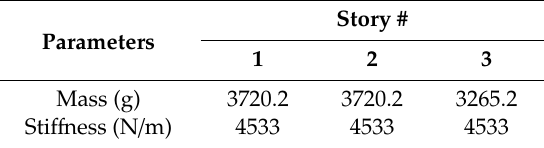
Table 5. Floor mass and story sti ff ness of test structure.